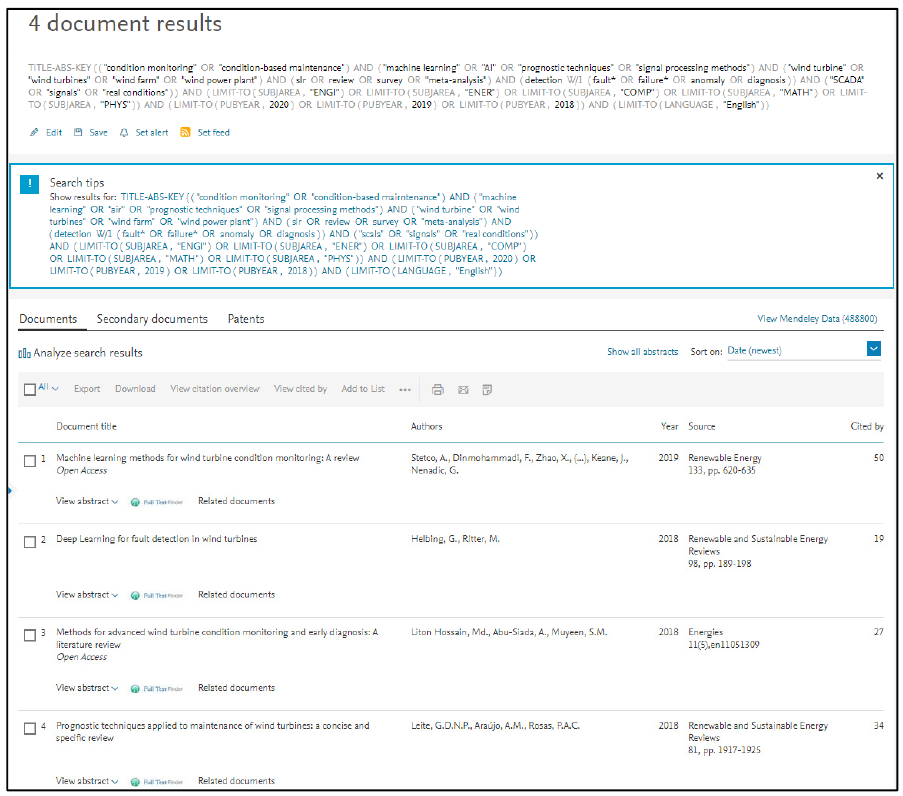
Figure 5. Scopus search result. Systematic literature review (SLR) related.